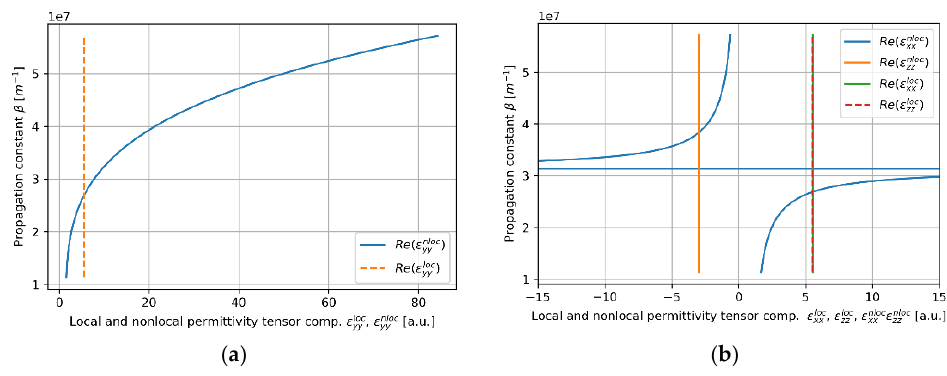
Figure 11. Real parts of components of effective local and nonlocal tensors (horizontal axis) of the core layer with dielectric layer thickness t Nb2O5 = 110 nm plotted versus propagation constant (vertical axis), which are encountered by TE ( a ) and TM waveguide modes ( b ).